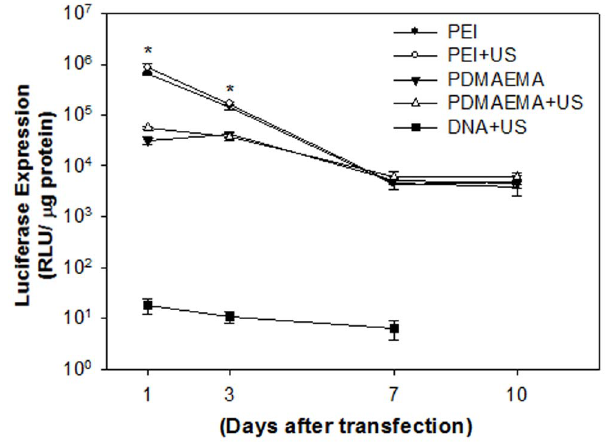
Figure 4. Invitro transgenic expression of PEI/DNA nanoparti- cles at an N/P ratio of 5 and PDMAEMA/DNA nanoparticles at a weight ratio of 10 with or without US exposure. The PEI mediated gene expression on day 1 was significantly higher than that of PDMAEMA regardless of US exposure. However, there was no difference after 7 days. *P , 0.05 vs. PDMAEAM.